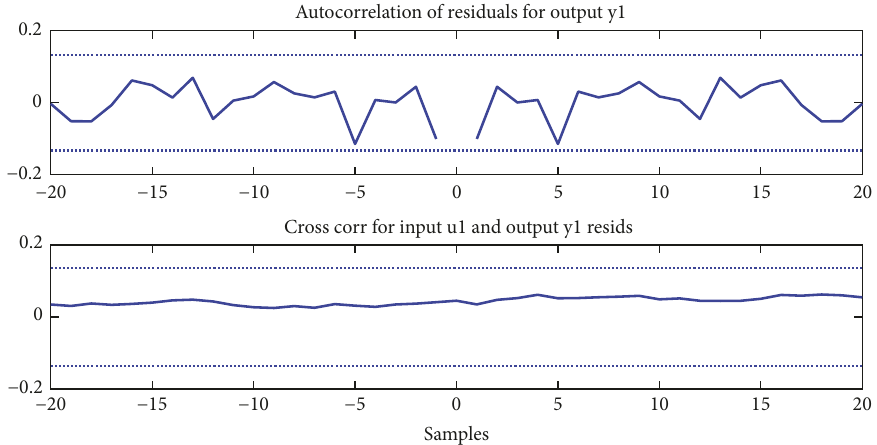
Figure 27: Autocorrelation y1 and cross-correlation of system responses u1 & y1.